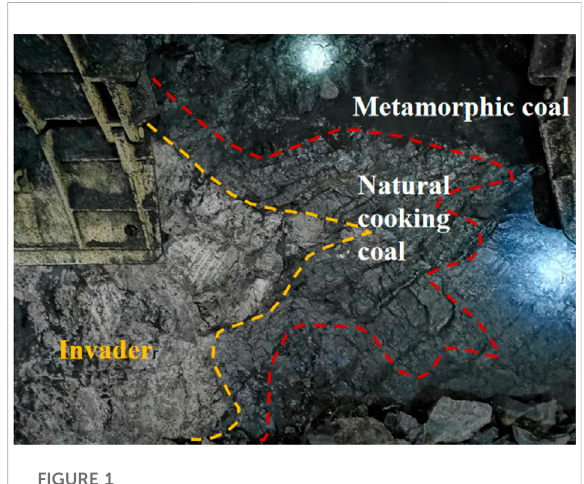
FIGURE 1 Thermally contacted metamorphic